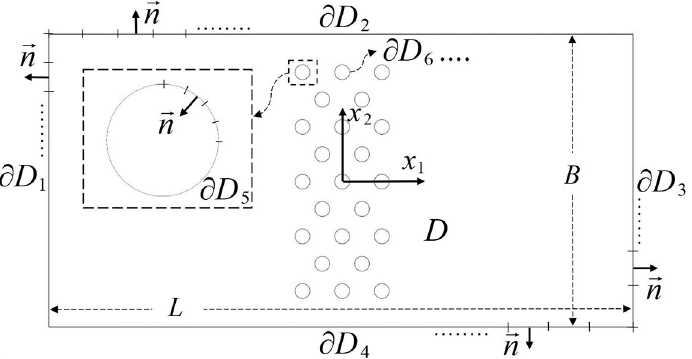
Figure 8. Indicative boundary mesh of ∂ D